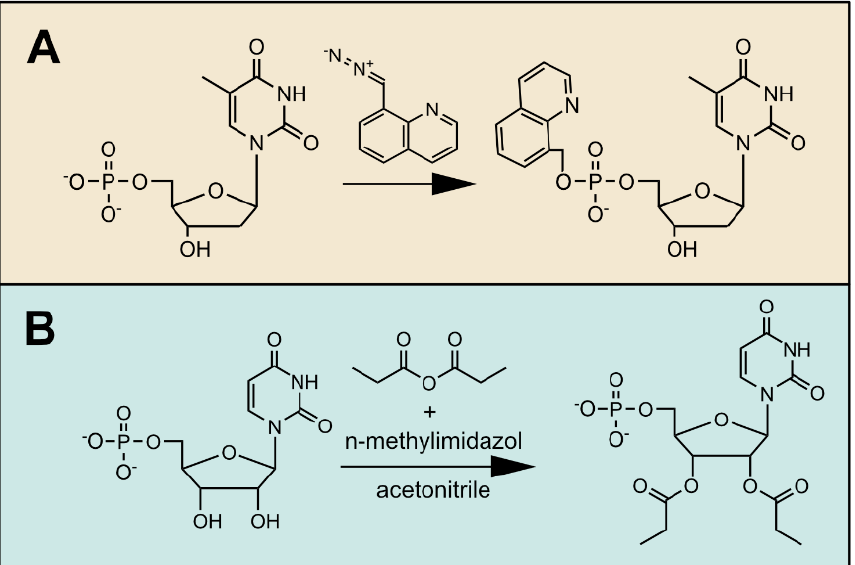
Figure 3. Examples of different derivatization strategies for nucleotides. ( A ) 8-(diazomethyl) quino- line reacts with the phosphate group neutralizing a negative charge; ( B ) propionic anhydride is used for the derivatization of hydroxyl groups. Both strategies reduce the polarity of the nucleotide and facilitate chromatographic separation, which fosters a more sensitive detection by mass spec- trometry.